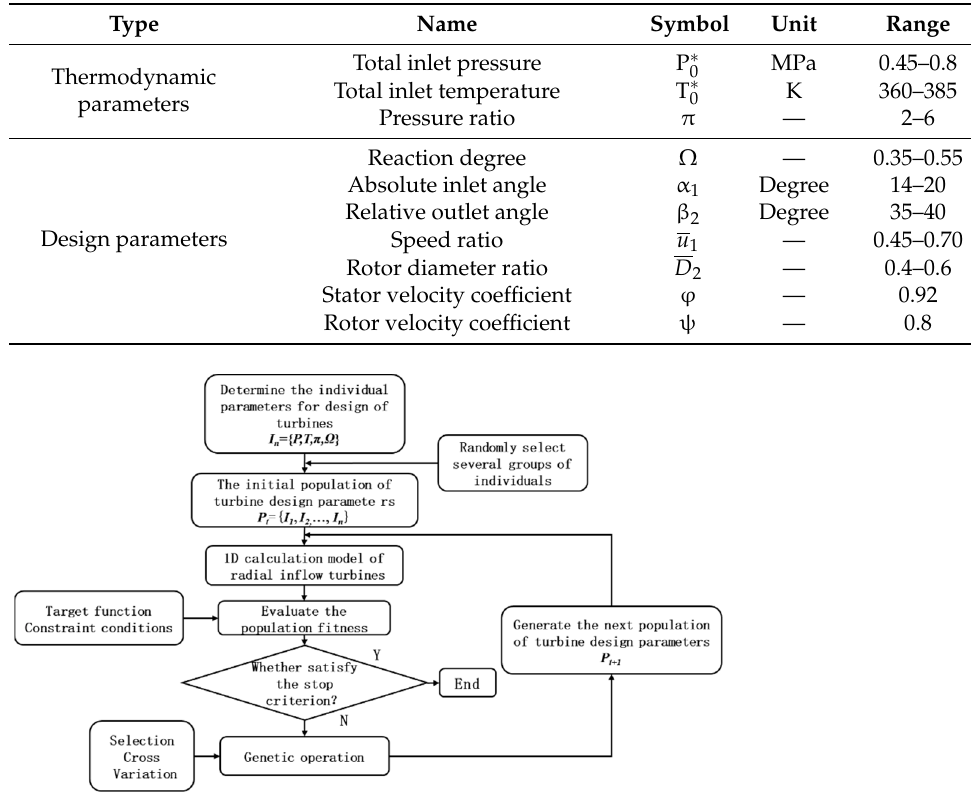
Table 1. Initial design parameters for radial inflow turbines.